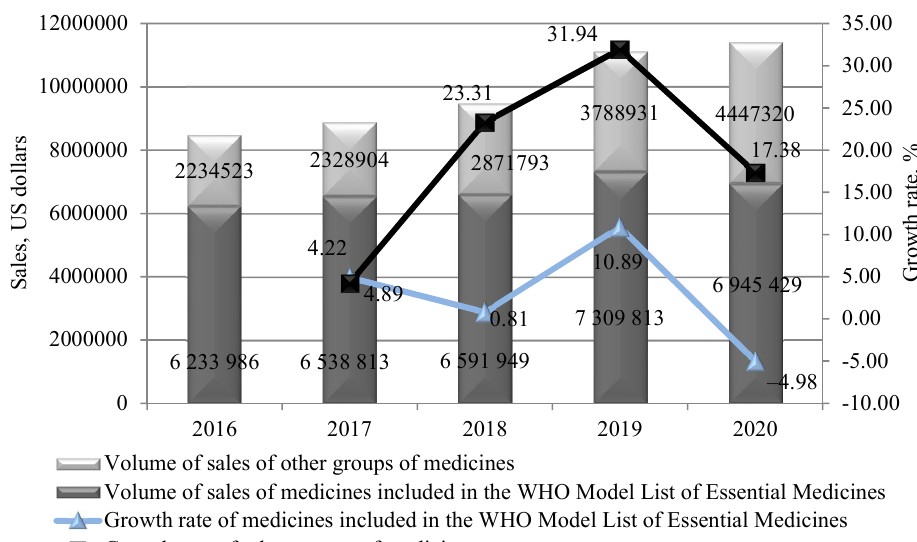
Fig. 12. Dynamics of indicators of sales volumes in cash of drugs included in the WHO Model List of Essential Medicines and other medicines for the pharmaceutical market of